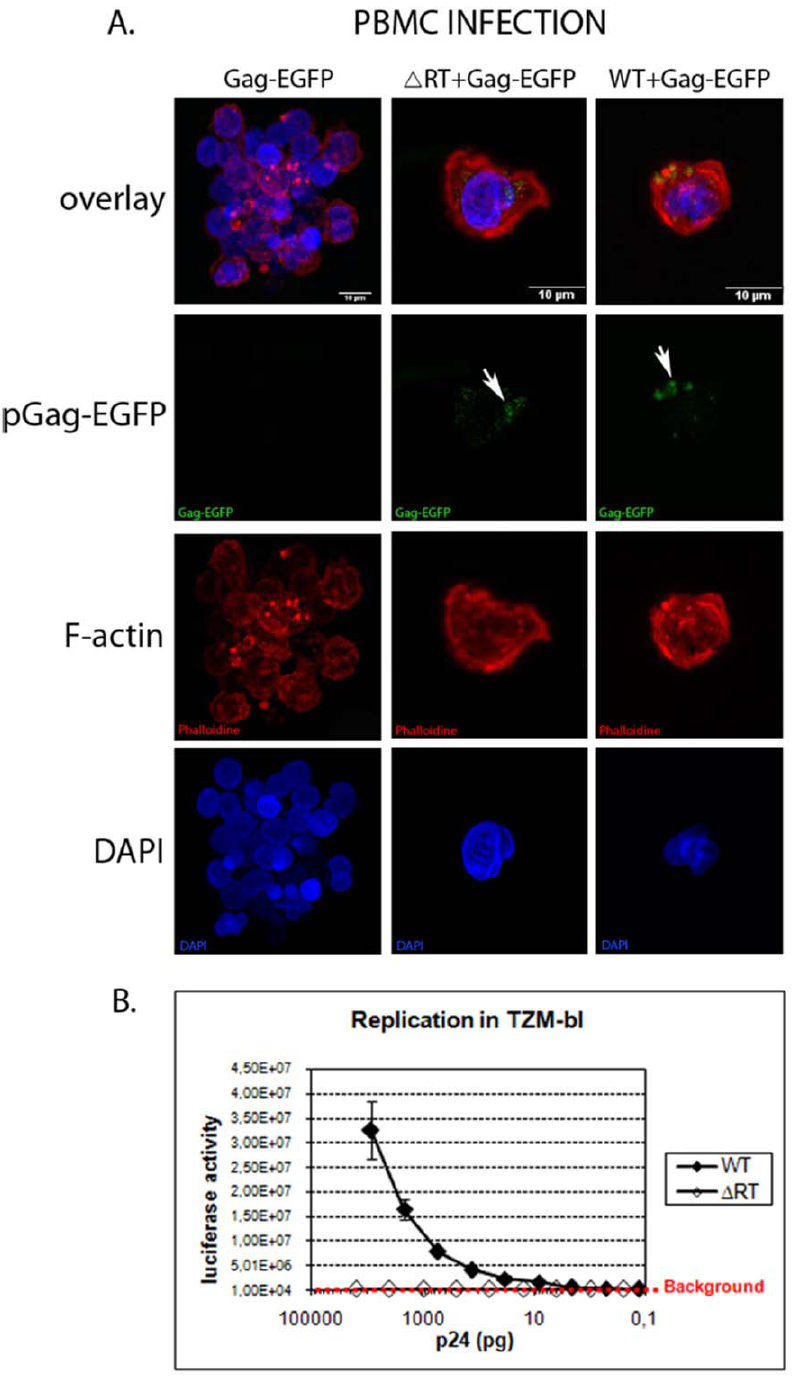
Figure 2. NL4-3/ D RT plasmid renders virions infectious but non-replicative. (A) PBMC infection was monitored using NL4-3 (WT) and NL4-3/ D RT ( D RT) virions labelled with a Gag fusion protein (Gag-EGFP). Samples were imaged using a Leica SP2 confocal microscope. We observed an accumulation of Gag-EGFP in the cells infected with NL4-3 and NL4-3/ D RT (arrows) but not in cells infected with Gag-EGFP. Cellular nuclei are stained in blue (DAPI), F-actin in red (Phalloidine) and the fusion protein Gag in green (Gag-EGFP). (B) NL4-3 and NL4-3/ D RT virion replication measurements by luciferase activity in TZM-bl cells. The NL4-3 virions showed a decrease in luciferase activity directly proportional to the p24 quantity, while for NL4- 3/ D RT virions, luciferase activity was under the background independently of the p24